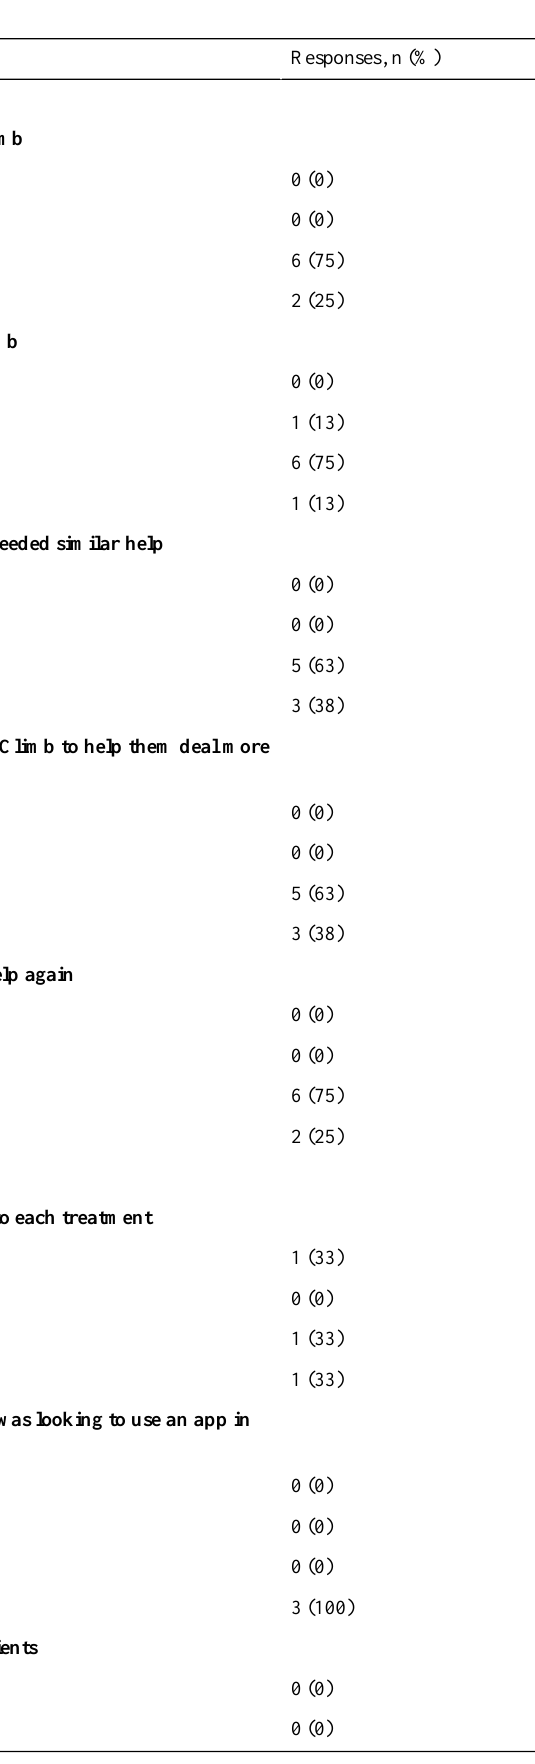
Table 4. Adolescent and therapist satisfaction with